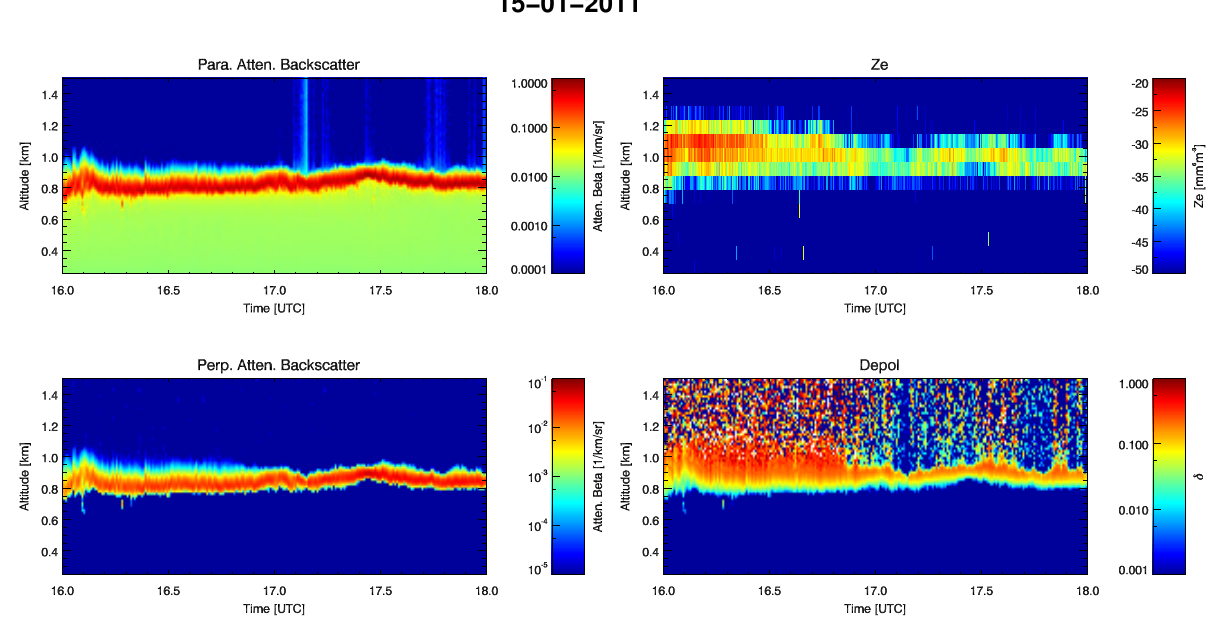
Figure 13. Observed lidar and radar signals for 15 January 2011 at Cabauw from 16:00 to